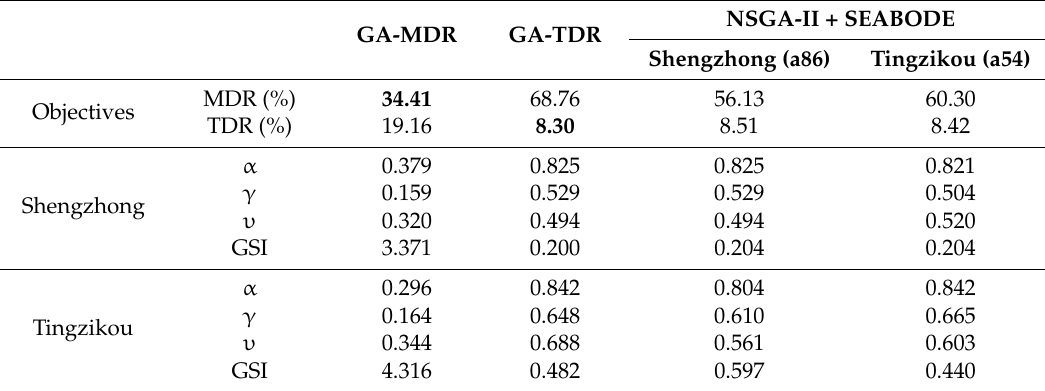
Table 7. Results of the preferred alternative and single objective